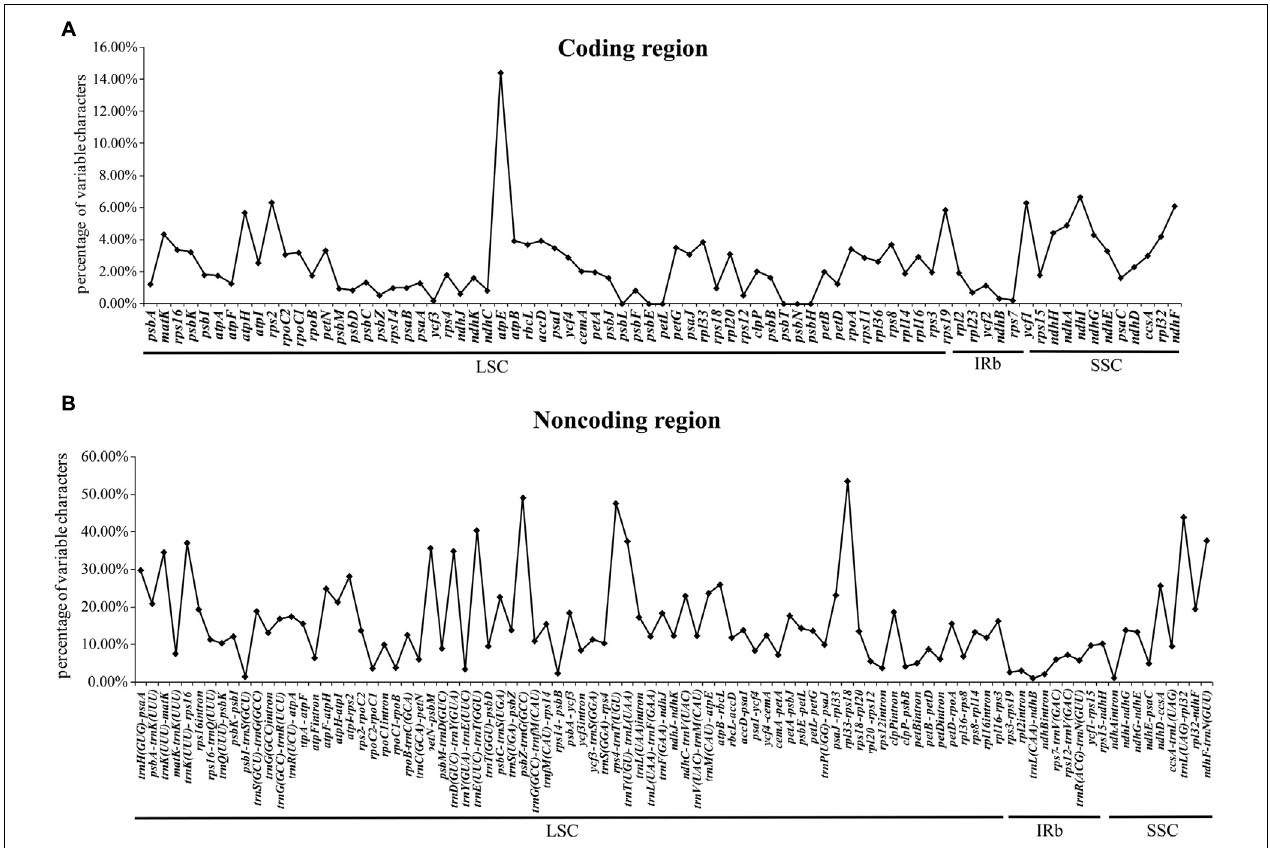
FIGURE 4 | Percentages of variable characters in homologous regions among Gossypium chloroplast genomes. (A) Coding regions. (B) Non-coding regions. The homologous regions are oriented according to their locations in the chloroplast